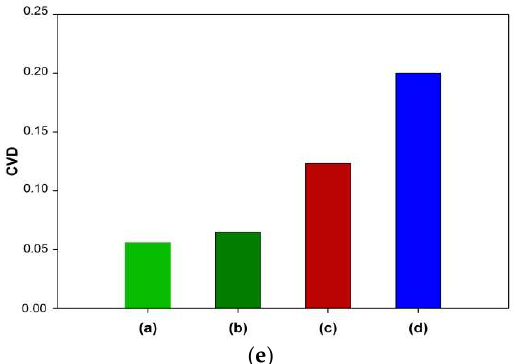
Figure 6. Change magnitude of phenological trajectory (or EVI curve) between 2010 and 2015. ( a ) phenological trajectory difference caused by different cropland type; ( b ) phenological trajectory difference caused by time scaling due to change of the rainy season; ( c ) trajectory difference caused by change from cropland to urban built-up; ( d ) trajectory difference caused by change from cropland to water; ( e ) change magnitude of four pair curves based on CVD.